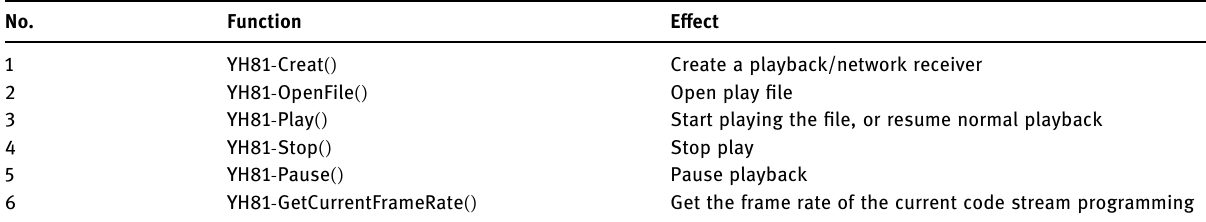
Table 5: Video decoding